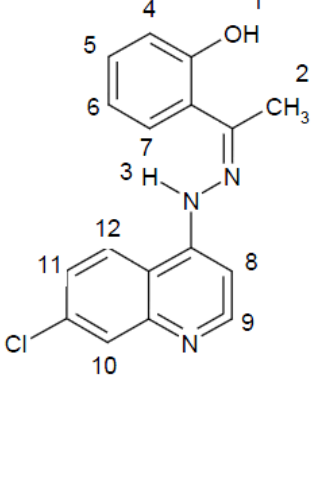
Figure 1. Structure and atom numbering of o -hydroxyacetophenone-7-chloro-4-quinoline hydrazine ( HL